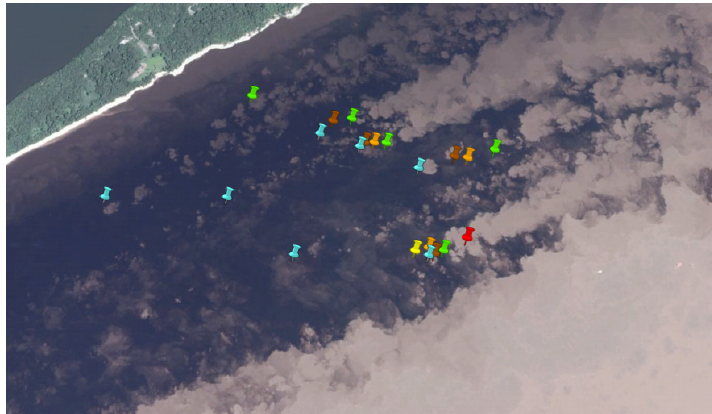
Figure 14. Boils of Solimões water on the Rio Negro side of the river. The markers show the most upstream locations of the boils for the available aerial photographs. Location shown in Figure